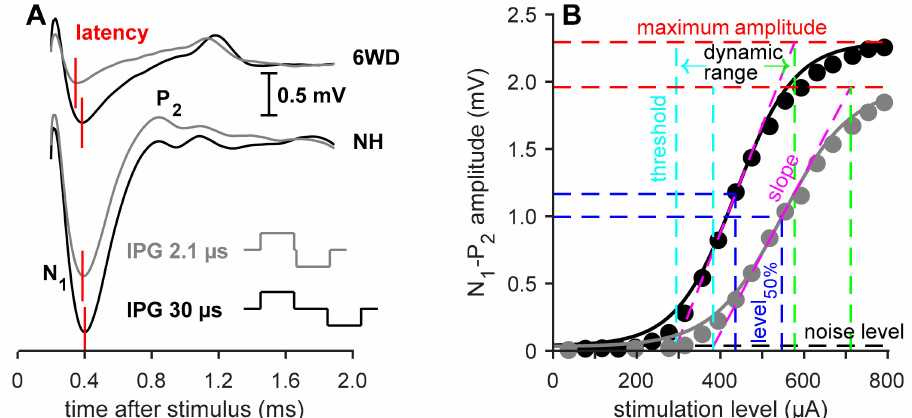
Figure 2. Examples of single pulse eCAP recordings. ( A ) eCAPs from an untreated 6 weeks deaf (6WD) and a normal-hearing (NH) animal with an IPG of 2.1 or 30 µ s. N 1 represents the first negative peak and P 2 represents the second positive peak of the waveform. The red vertical lines indicate the N 1 latency of the eCAP. ( B ) Input-output functions from N 1 -P 2 amplitude in the same NH animal of A both an IPG of 2.1 µ m (gray) and 30 µ s (black). The line represents the Boltzmann curve fit (Equation (1)). The dashed, colored lines represent the various eCAP characteristics derived from the aforementioned Boltzmann equation. IPG: inter-phase gap.